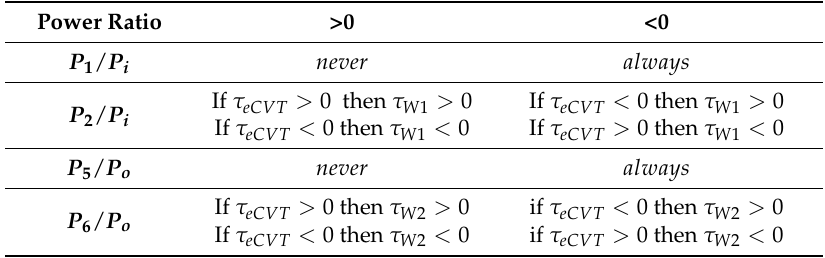
Table 6. Case 3—Power ratios